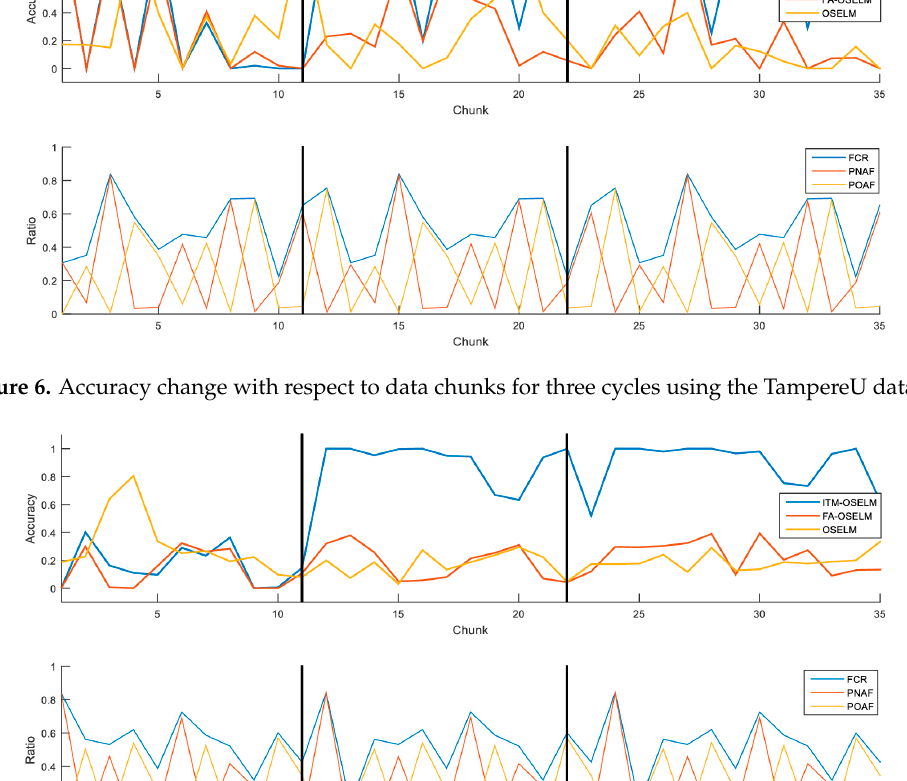
Figure 8. Accuracy change with respect to data chunks for three cycles using the KDD99 dataset.